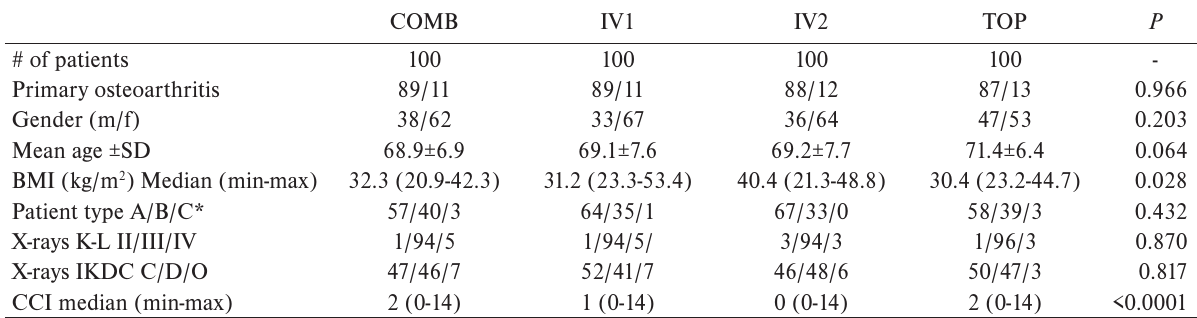
Table 1. Comparison of the groups in their basic parameters.